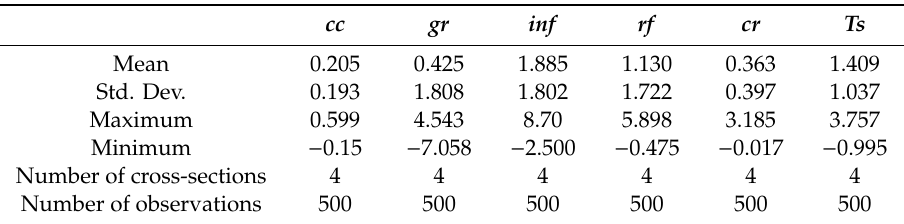
Table 4. Summary statistics of